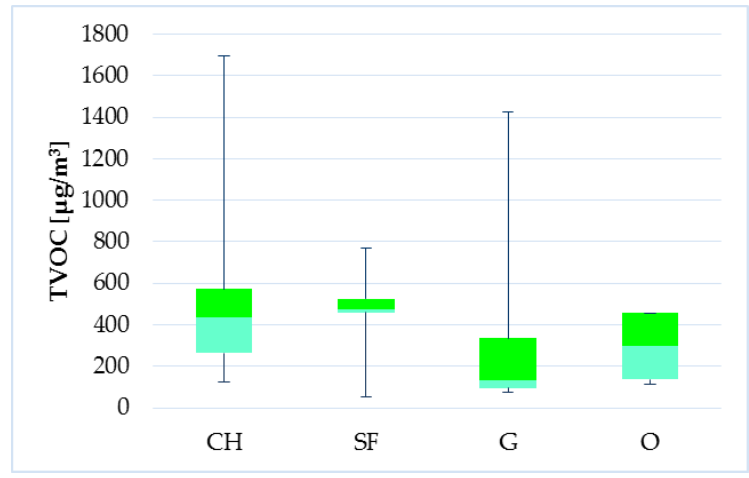
Figure 22. Boxplot of total medians—type of heating.